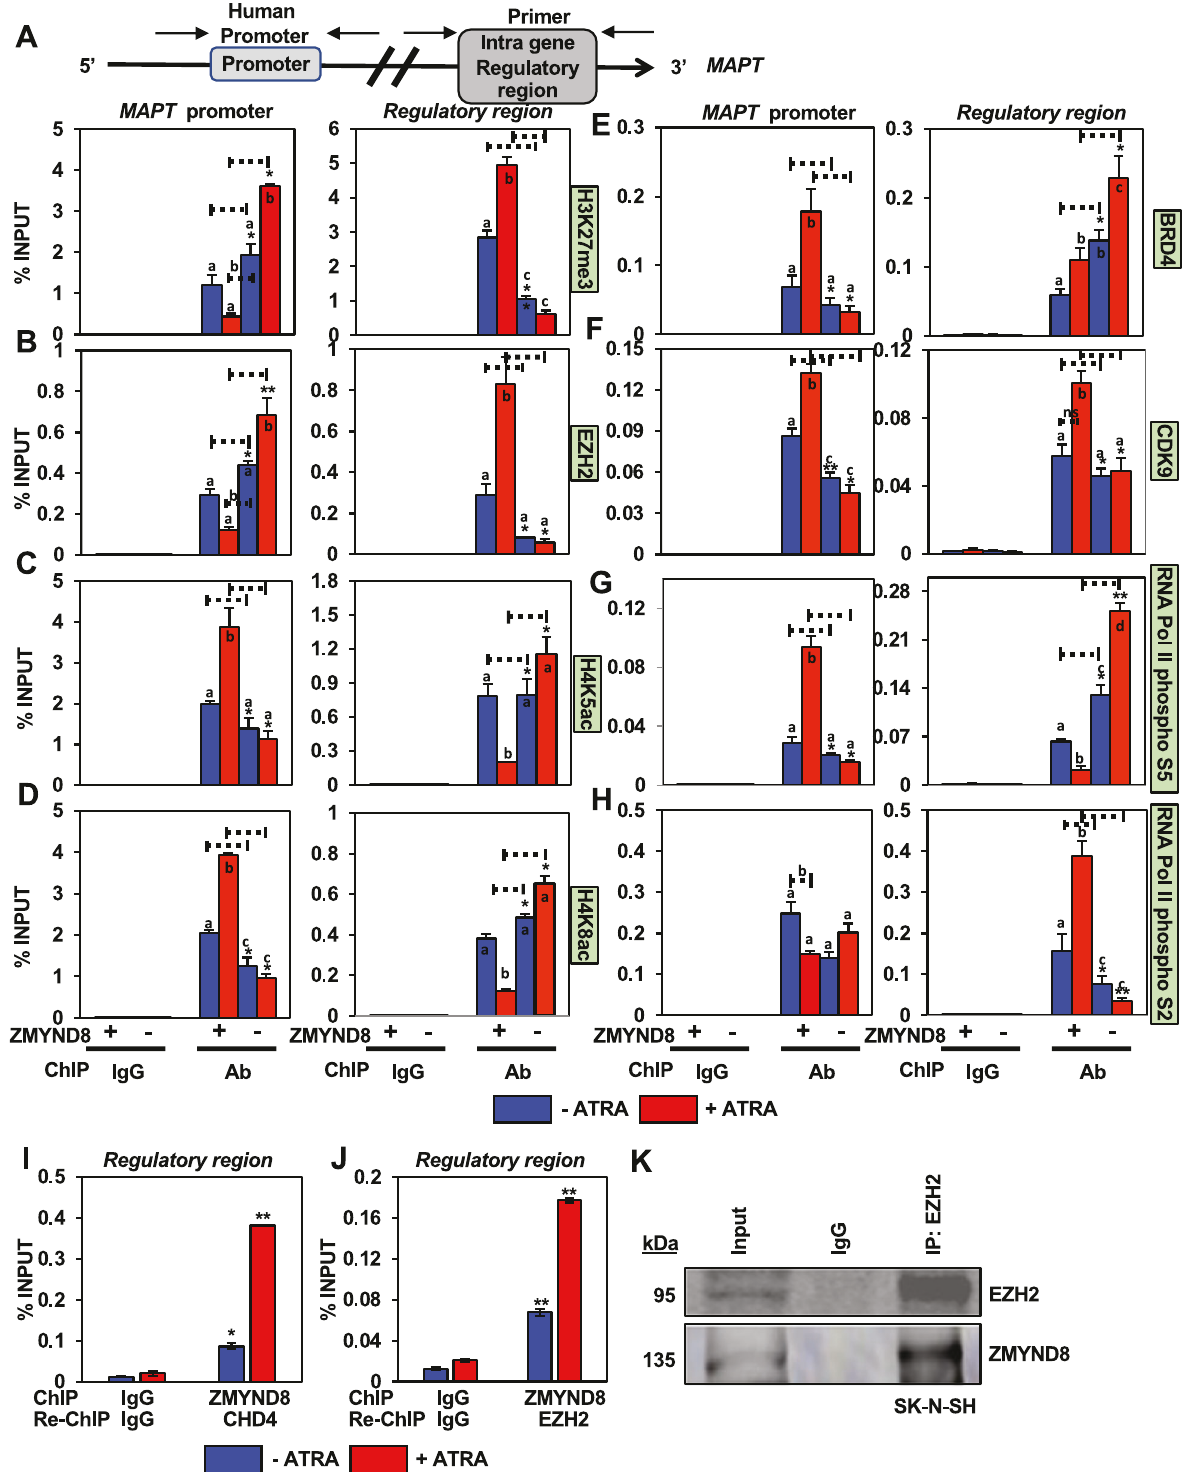
Fig. 6 ZMYND8 switches to the transcription activating epigenetic landscape at the intra-gene regulatory region of MAPT . A – H Bar plots of qPCR showing enrichment of H3K27me3 ( A ), EZH2 ( B ), H4K5ac ( C ), H4K8ac ( D ), BRD4 ( E ), CDK9 ( F ), RNA pol II phosphoS5 ( G ), and RNA pol II phosphoS2 ( H ) at the MAPT promoter and IGRR in ZMYND8 -knockout ( ZMYND8 -KO) or control SK-N-SH cells with or without ATRA treatment. I , J Re-ChIP assays show ZMYND8 forms complex with CHD4 (subunit of NuRD) ( I ) and EZH2 (subunit of PRC2) ( J ) at the IGRR site. Error bars indicate sem.; n = 3; three independent experiments. A two-tailed t -test was used to calculate P -values. * P < 0.05; ** P < 0.01. One-way ANOVA was used to compute statistical differences. Boxes marked with a, b, and c are signi fi cantly different from each other padj-value = < 0.05. K Coimmunoprecipitation shows an association between EZH2 and ZMYND8.